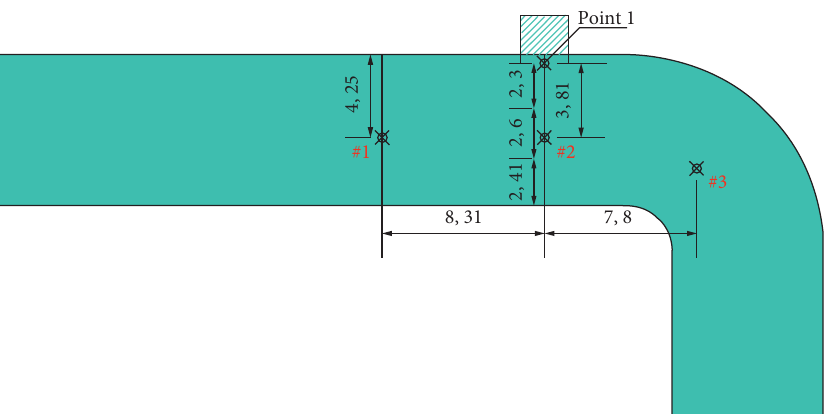
Figure 4: Channel model and measuring